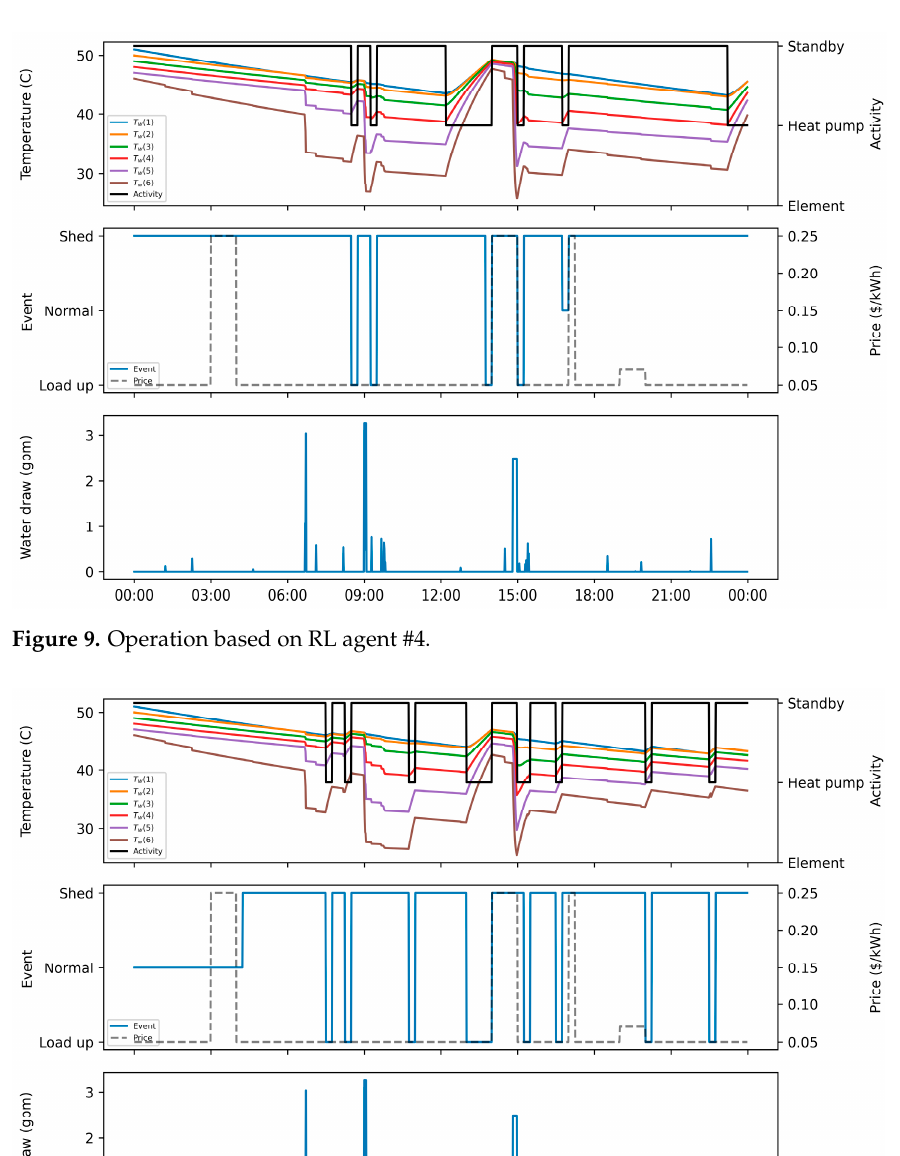
Figure 9. Operation based on RL agent #4.